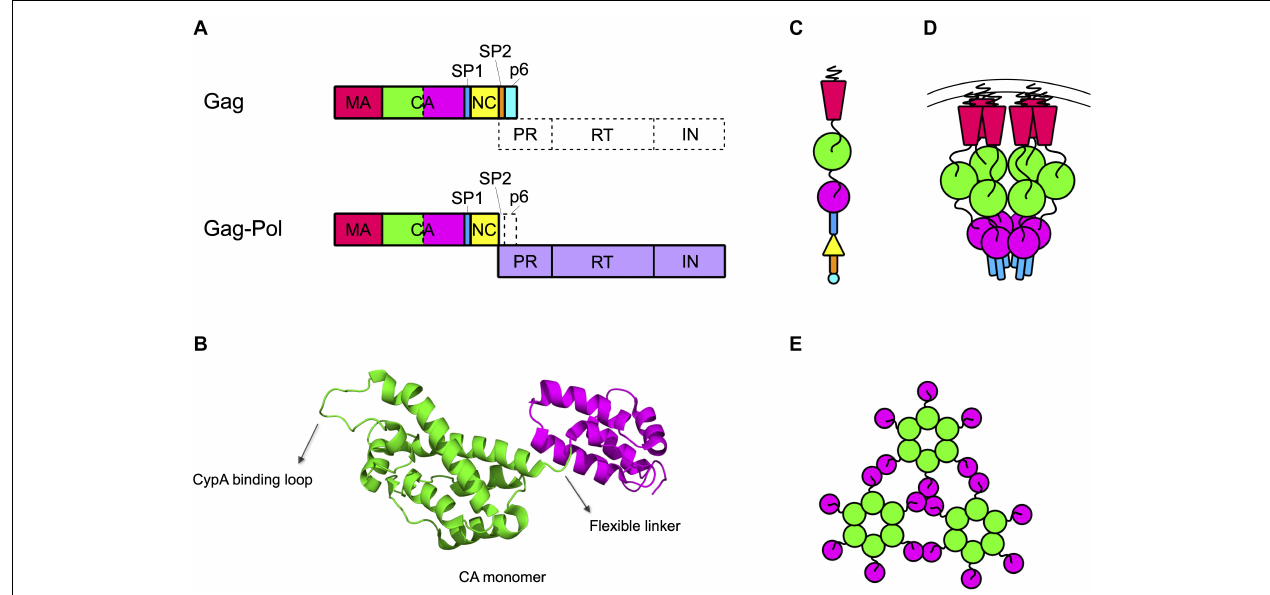
FIGURE 1 | Capsid forms throughout the HIV life cycle. (A) Gag and Gag-Pol precursors simplified structures. Gag precursor includes the matrix protein (MA), the capsid (CA, depicted with the NTD in green and the CTD in magenta), the spacer peptide 1 (SP1), the nucleocapsid (NC), the spacer peptide 2 (SP2), and the peptide 6 (p6). A frameshift during translation allows the production of Gag-Pol precursor, with a ratio of 1:20 with respect to the Gag precursor. In this structure the NC is fused to the protease (PR), the reverse transcriptase (RT), and the integrase (IN) domains. (B) Structure of CA monomer. CA is composed of two domains connected by a flexible linker: the NTD (in green), formed by a beta-hairpin and seven alpha-helices, and the CTD (in magenta), formed by four alpha-helices. The CypA binding loop in the NTD is indicated. PDB ID: 6WAP (Lu et al., 2020). (C) Schematic structure of the Gag precursor composed from top to bottom of MA, CA-NTD, CA-CTD, SP1, NC, SP2, and p6. (D) Schematic structure of a hexamer in the immature lattice, after the first proteolytic cleavage, which occurs between SP1 and NC. The MA are attached to the membrane through their myristoylated domain. Proceeding toward the center of the viral particle there are three hexameric